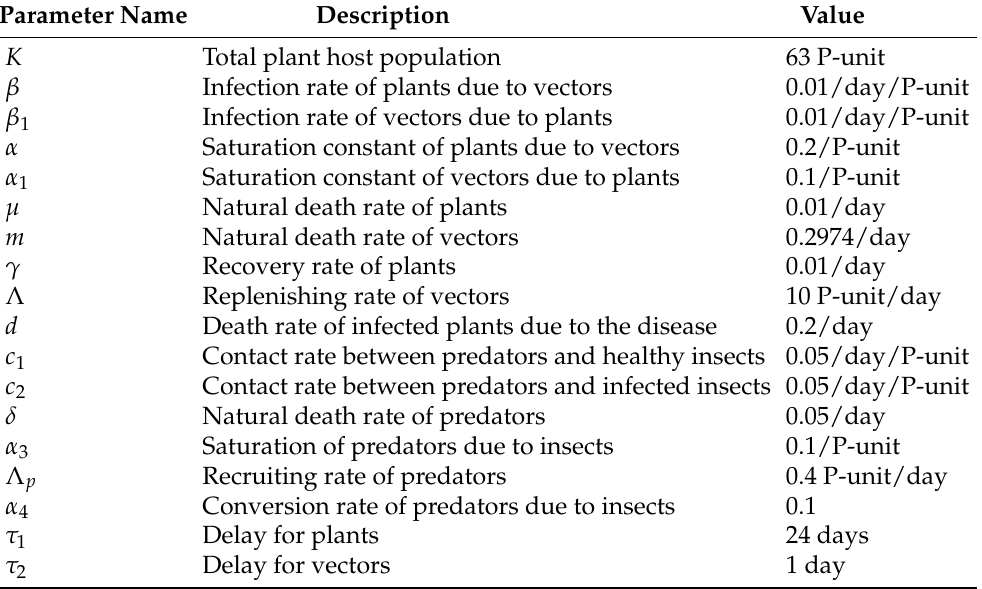
Table 1. Values for the parameters of the virus